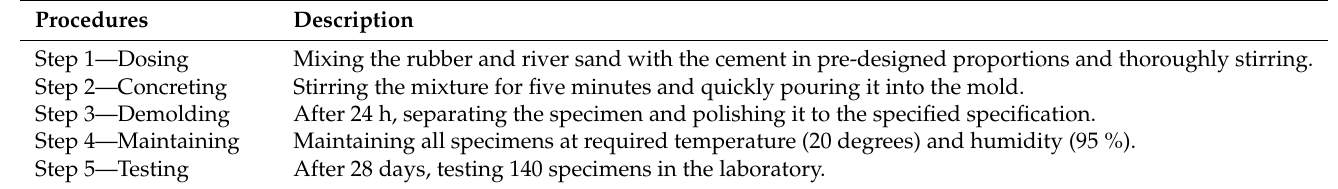
Table 1. A brief description of the preparation procedure for novel concrete specimen.